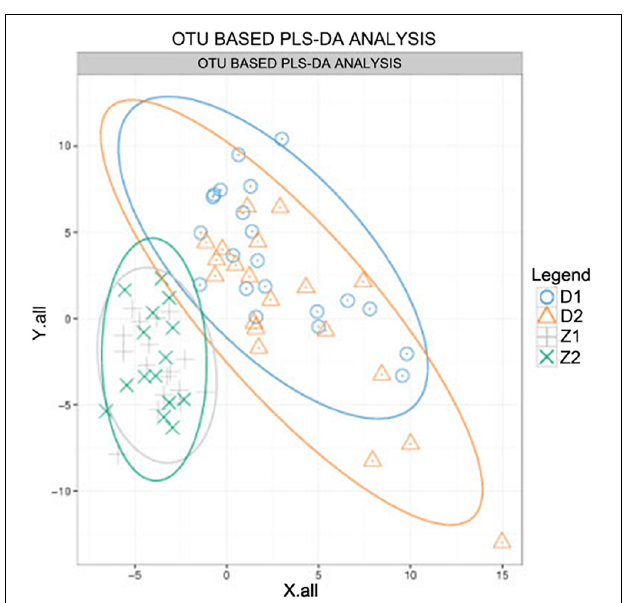
FIGURE 3 | The PLS-DA analysis of OTU determination in the Electroacupuncture group and the Control group (Z1, the Electroacupuncture group before treatment; Z2, the Electroacupuncture group after treatment; D1, the Control group before treatment; D2, the Control group after treatment).